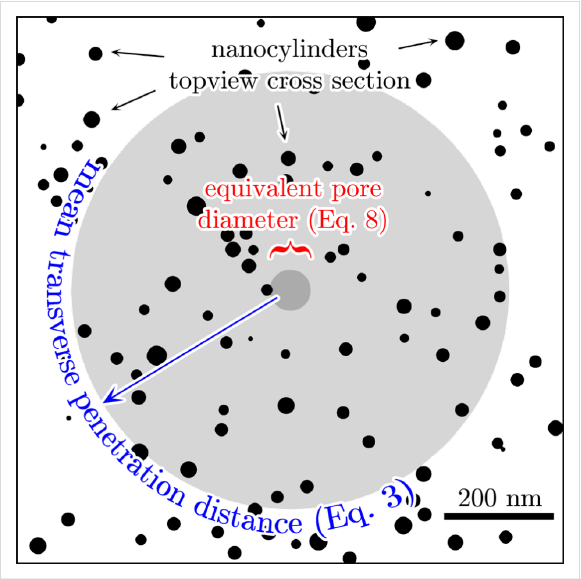
Figure 4: Illustration of the equivalent pore diameter (Equation 8) and the mean transverse penetration distance calculated using Equation 3. Diameters of nanocylinders are normally distributed with a mean value of 25 nm and a standard deviation of 6 nm. The nanocylinders are uniformly distributed on the substrate with an areal density of 10 10 cm − 2